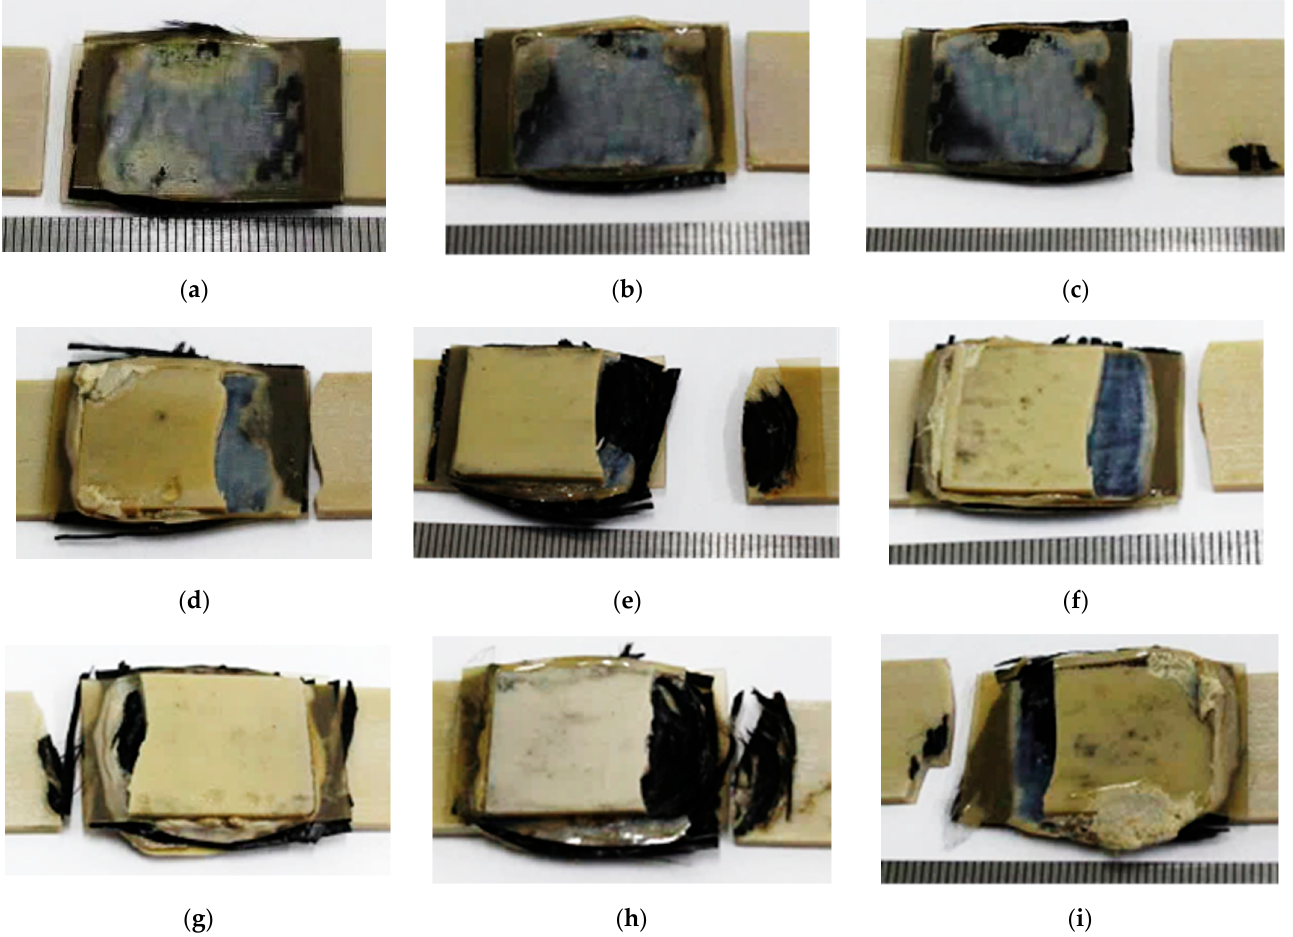
Figure 5. General view photos of the fractured USW lap joints after the tensile tests (( a – i ), for modes 1–9, respectively).